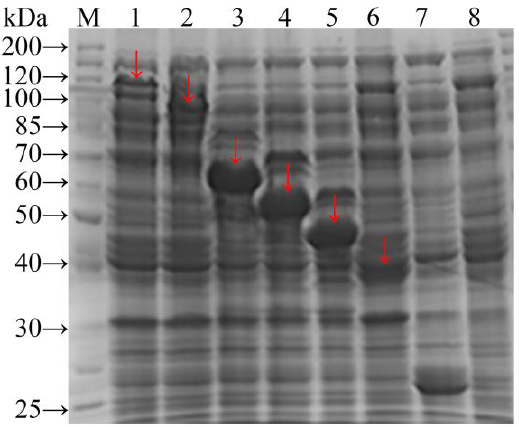
Figure 3. SDS-PAGE electrophoretogram of E. coli BL21 total proteins. Lane M: protein molecular weight standards. Lanes 1 – 7: containing the expression vector pGEX- gs16f12 , pGEX- gs16f8 , pGEX- gs16f4 , pGEX- gs16f3 , pGEX- gs16f2 , pGEX- gs16f1, and pGEX- AgeI , respectively. Lane 8: not